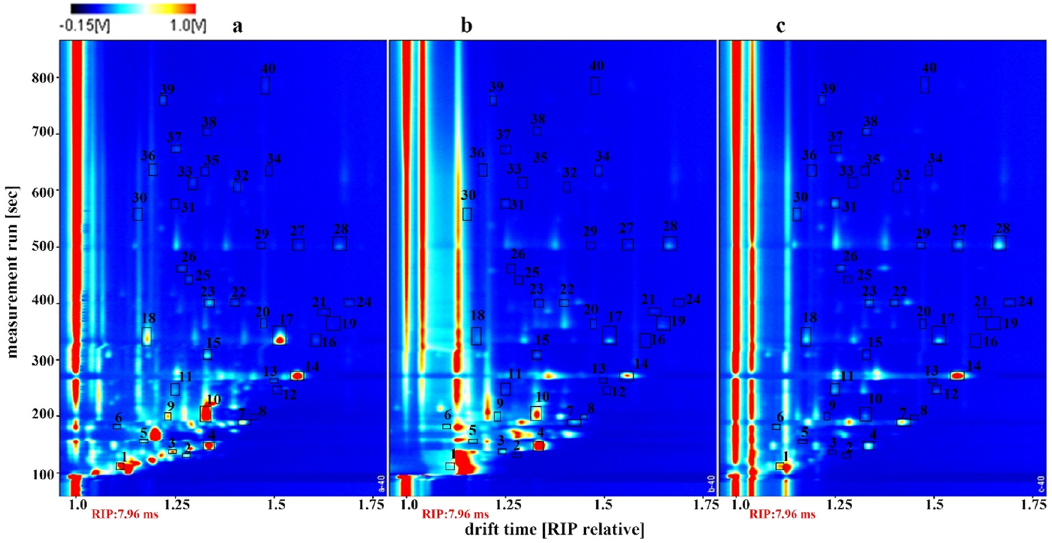
Figure 4: GC – IMS plot with the extended markers obtained from di ff erent extraction methods: ( a ) squeezing extracted; ( b ) supercritical carbon dioxide extracted; ( c ) aqueous extracted. The Arabic numerals from “ 1 ” to “ 40 ” correspond to the identi fi ed signals. Signal “ 1 ” represents 1 - propanol, “ 2 ” butanal, “ 3 ” 2 - butanone, “ 4 ” ethyl acetate, “ 5 ” 2,3 - butanedione, “ 6 ” propanoic acid, “ 7 ” pentanal, “ 8 ” ethyl propionate, “ 9 ” 2 - methyl butanol, “ 10 ” 3 - hydroxy - 2 - butanone, “ 11 ” 1 - pentanol M, “ 12 ” 1 - pentanol D, “ 13 ” 2 - hexanone, “ 14 ” n - hexanal, “ 15 ” 2 - furfural, “ 16 ” 3 - methyl - 1 - pentanol, “ 17 ” E 2 - hexen - 1 - ol, “ 18 ” 2 - hexen - 1 - ol, “ 19 ” 1 - hexanol, “ 20 ” 2 - methylbutanoic acid, “ 21 ” 2 - hepta - none, “ 22 ” methional, “ 23 ” heptanal M, “ 24 ” heptanal D, “ 25 ” methyl hexanoate, “ 26 ” 3 - methyl valeric acid M, “ 27 ” 5 - methylfurfuryl alcohol, “ 28 ” E 2 - heptenal, “ 29 ” benzaldehyde, “ 30 ” 1 - octene - 3 - ol, “ 31 ” 2 - pentylfuran, “ 32 ” octanal, “ 33 ” 1,8 - cineole M, “ 34 ” 2 - acetyl - thiazole, “ 35 ” benzyl alcohol, “ 36 ” E,E 2,4 - heptadienal, “ 37 ” 2 - phenylacetaldehyde M, “ 38 ” E 2 - octenal M, “ 39 ” linalool, “ 40 ” n - nonanal.